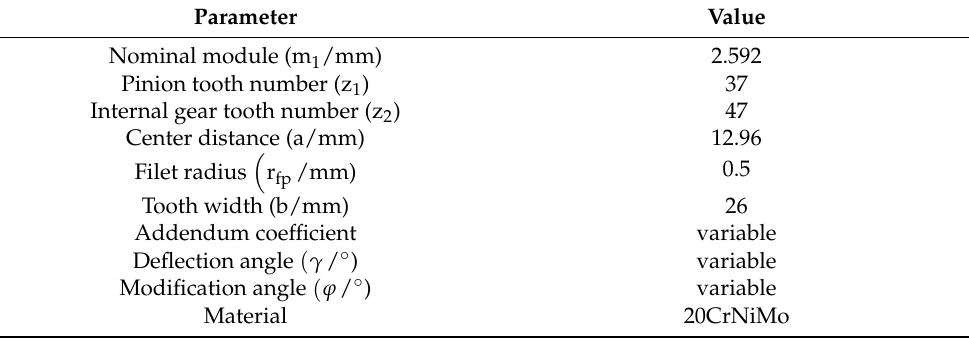
Table 1. Design and modification parameters of HCR internal spur gear drive.